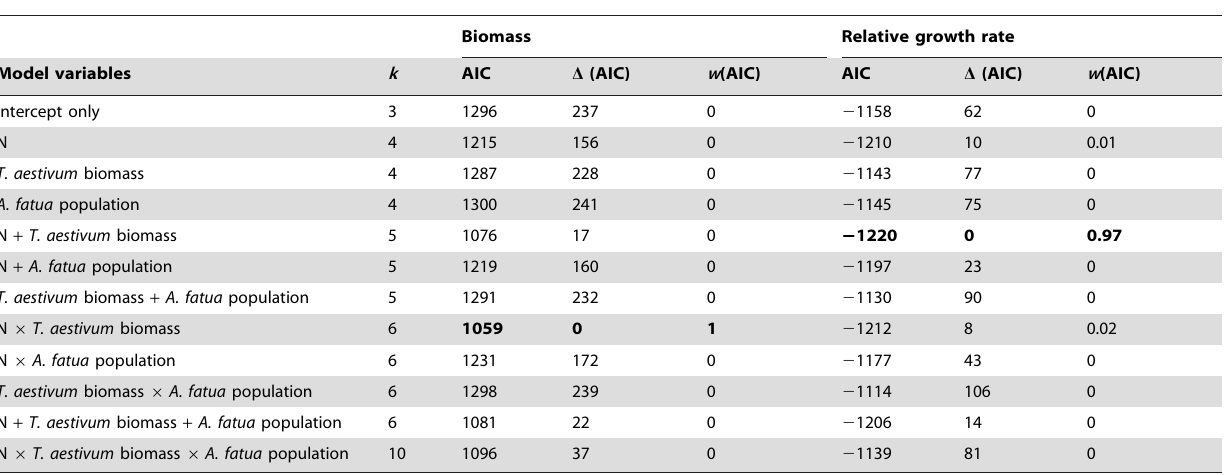
Table 2. Models predicting Avena fatua biomass and growth